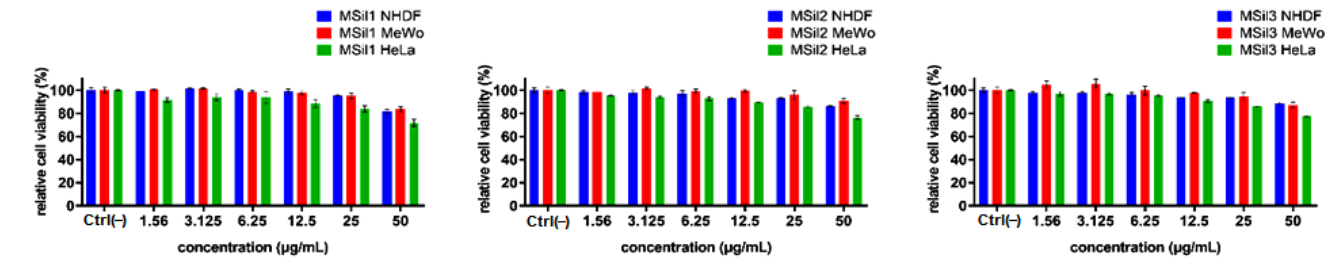
Figure 10. Cell viability of mesoporous silica materials before Dox